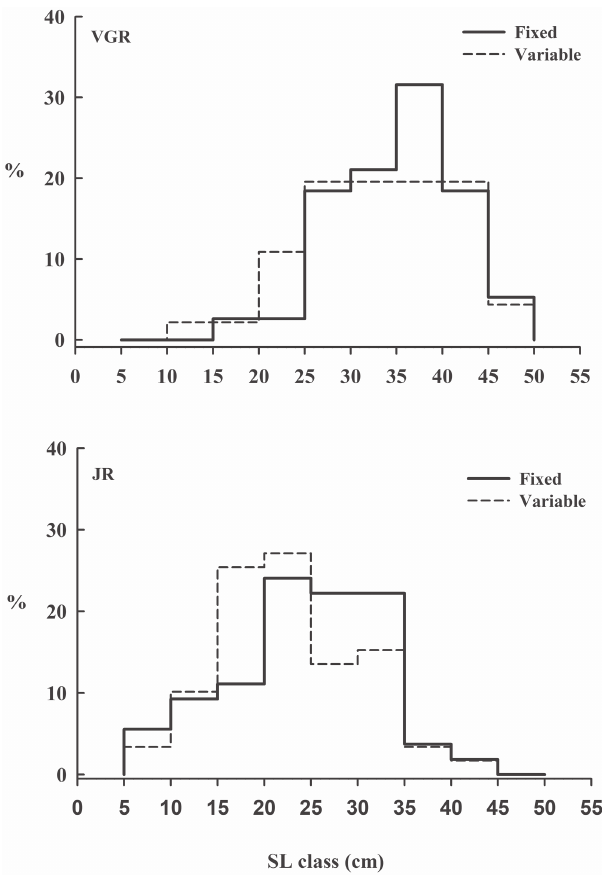
Fig. 5. Relationship between standard length (SL) and cap- ture distance for curimba at fixed and variable sampling sites of Volta Grande (VGR) and Jaguara (JR) reservoirs. Tab. 3. Effect size ( w ) for proportion of individuals